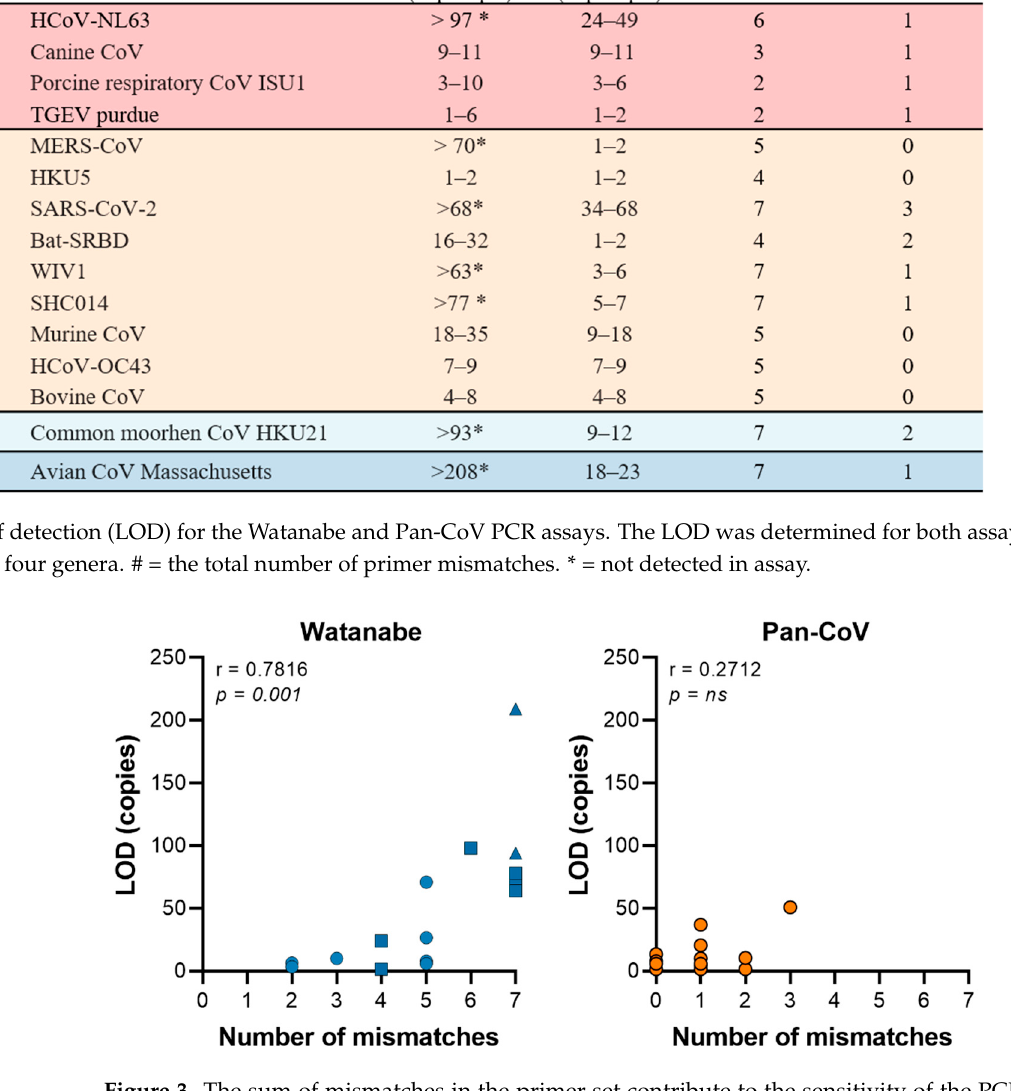
Figure 3. The sum of mismatches in the primer set contribute to the sensitivity of the PCR assay. Graph displaying the sum of mismatches within primer sets against the average limit of detection (LOD) per virus. A significant correlation was found for the Watanabe primers, but not the Pan-CoV primers using a Spearman’s rank correlation coefficient. Circle = no mismatches in 3 ′ end primer; square = 1 mismatch in 3 ′ end primer; triangle = >1 mismatch in 3 ′ end primer.